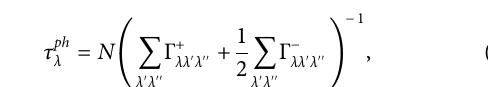
Frontiers in Materials |